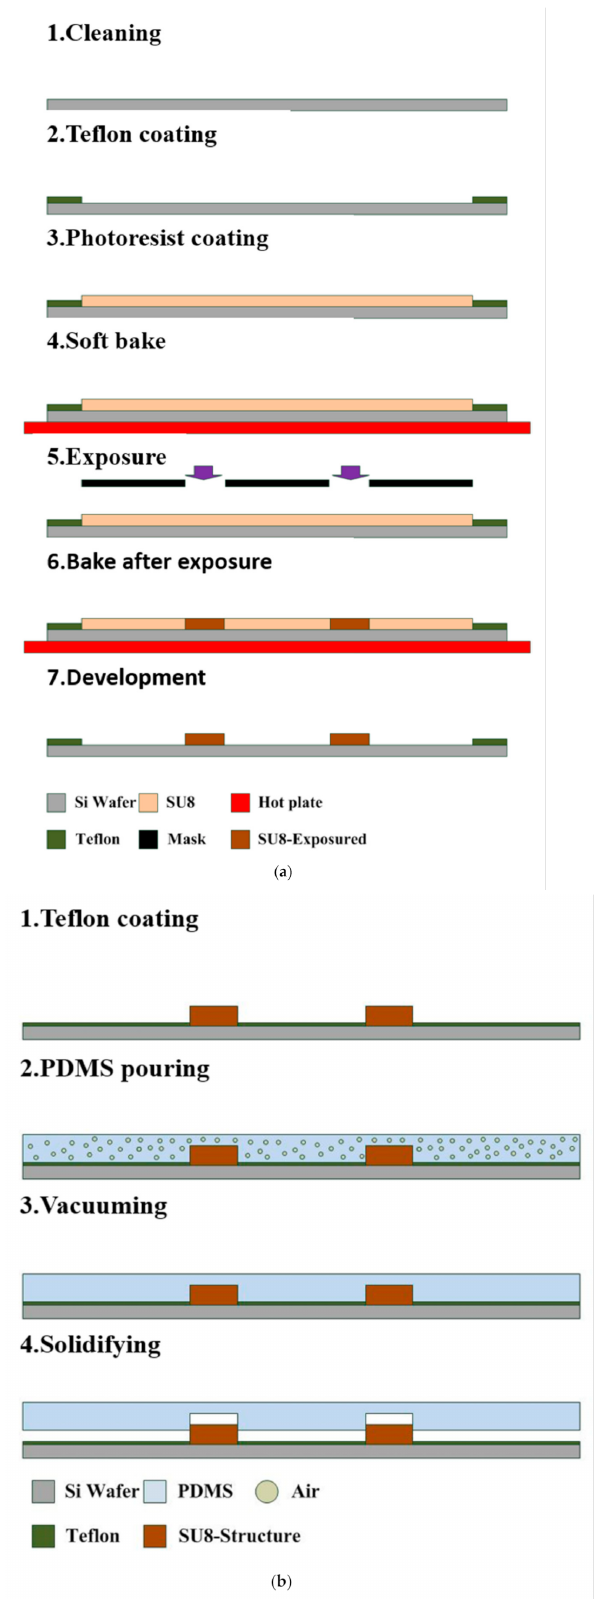
Figure 2. Fabrication of the microfluidic channels: ( a ) SU8 mold chip; ( b ) PDMS substrate microfluidic channel